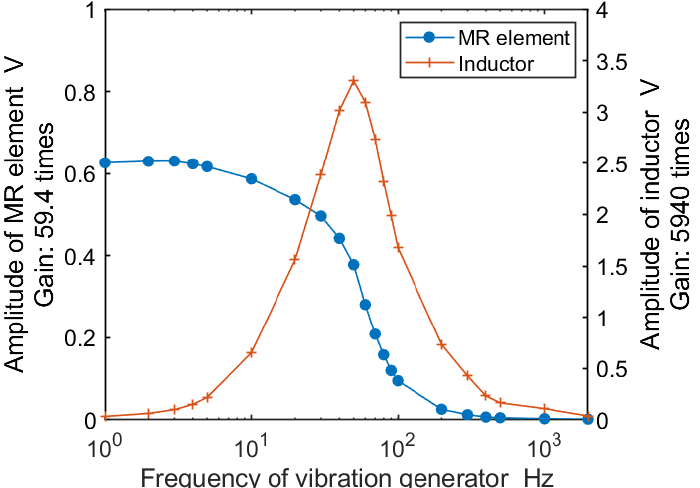
Figure 8. Relationship between the frequency and amplitude in terms of the voltage of the MR element and inductor in the vibration range from 1–2000